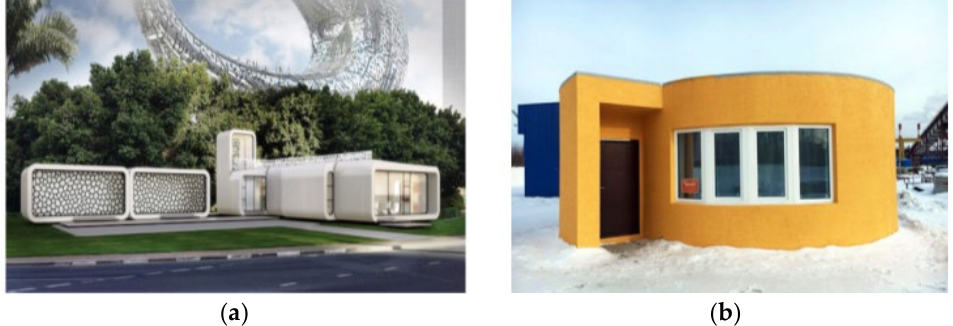
Table 1. Summary of selected major 3D-printed construction projects.